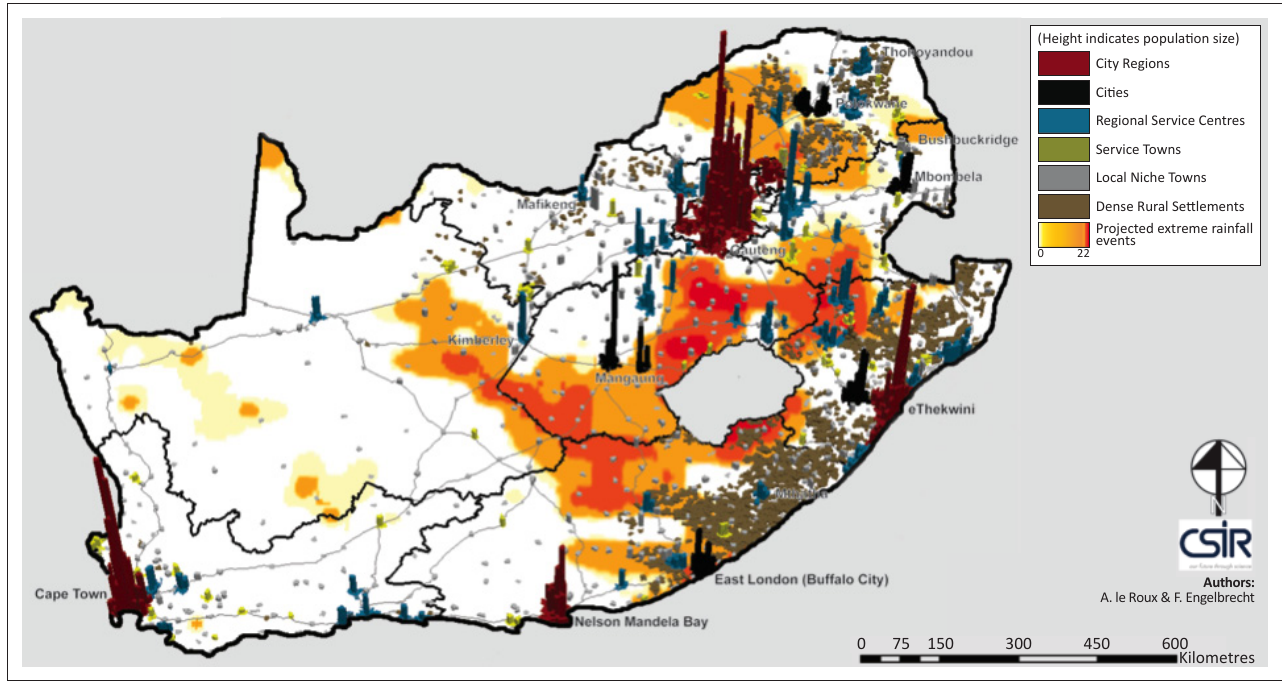
FIGURE 3: A map depicting the total population in 2007 (height of bar graphs) of various South African settlements (CSIR mesoframe 2010) and the projected change in the frequency of extreme rainfall events (CSM and EH). Such events are defined as 20 mm of rain or more that occurs within a 24-hour period per 50 km 2 x 50 km 2 grid box, for the near-future period, 2011–2040, relative to 1961–1990. Units of the rainfall variable are the number of rainfall